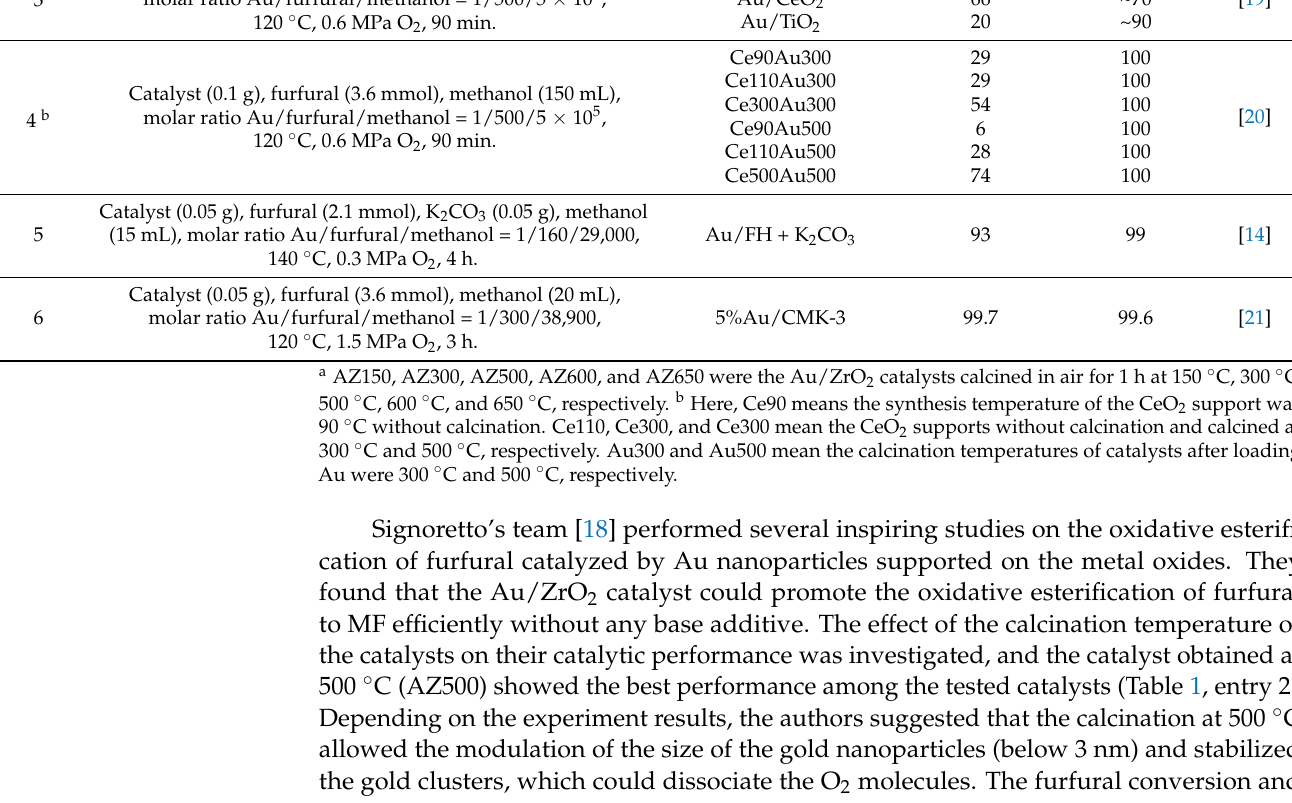
Furfural MF Conversion Selectivity (%) (%)